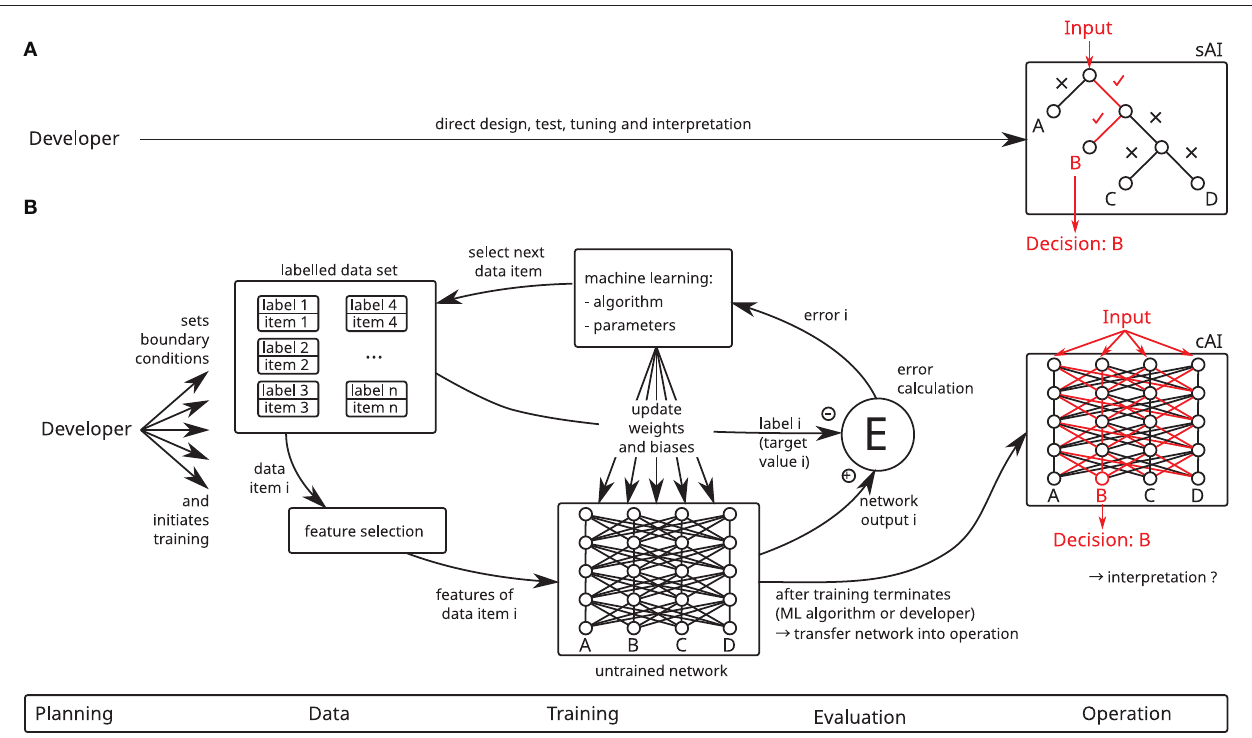
FIGURE 1 | Contrasting the development of (A) symbolic AI (sAI) and (B) connectionist AI (cAI) systems. Whereas sAI systems are directly designed by a human developer and are straightforward to interpret, cAI systems are trained by means of machine learning (ML) algorithms using large data sets (this figure shows supervised learning using a labeled data set). Due to their indirect design and their distributed decision-making, cAI systems are very hard to